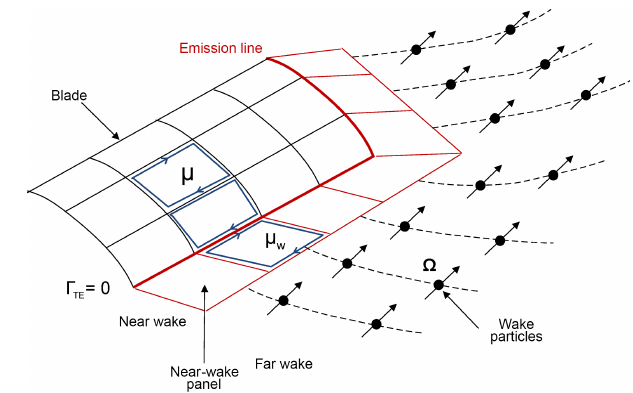
Figure 10. Layout of the free-wake modeling of a blade: black lines define the blade surface panels, red lines define the wake generated within a time step, and symbols represent freely moving